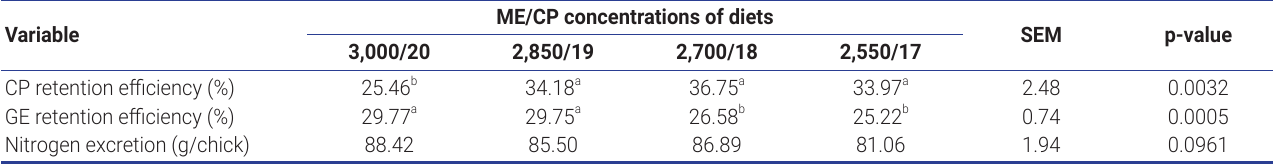
ME, metabolizable energy; CP, crude protein; SEM, standard error of the means; GE, gross energy. a,b Means with different superscripts within each row indicate differences